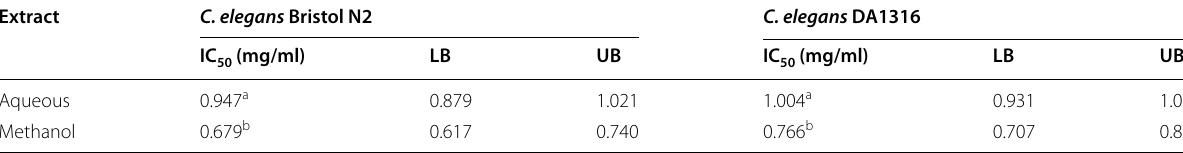
Table 2 IC of G. senegalensis extracts against C. elegans L4 larvae after 48 h of exposure 50